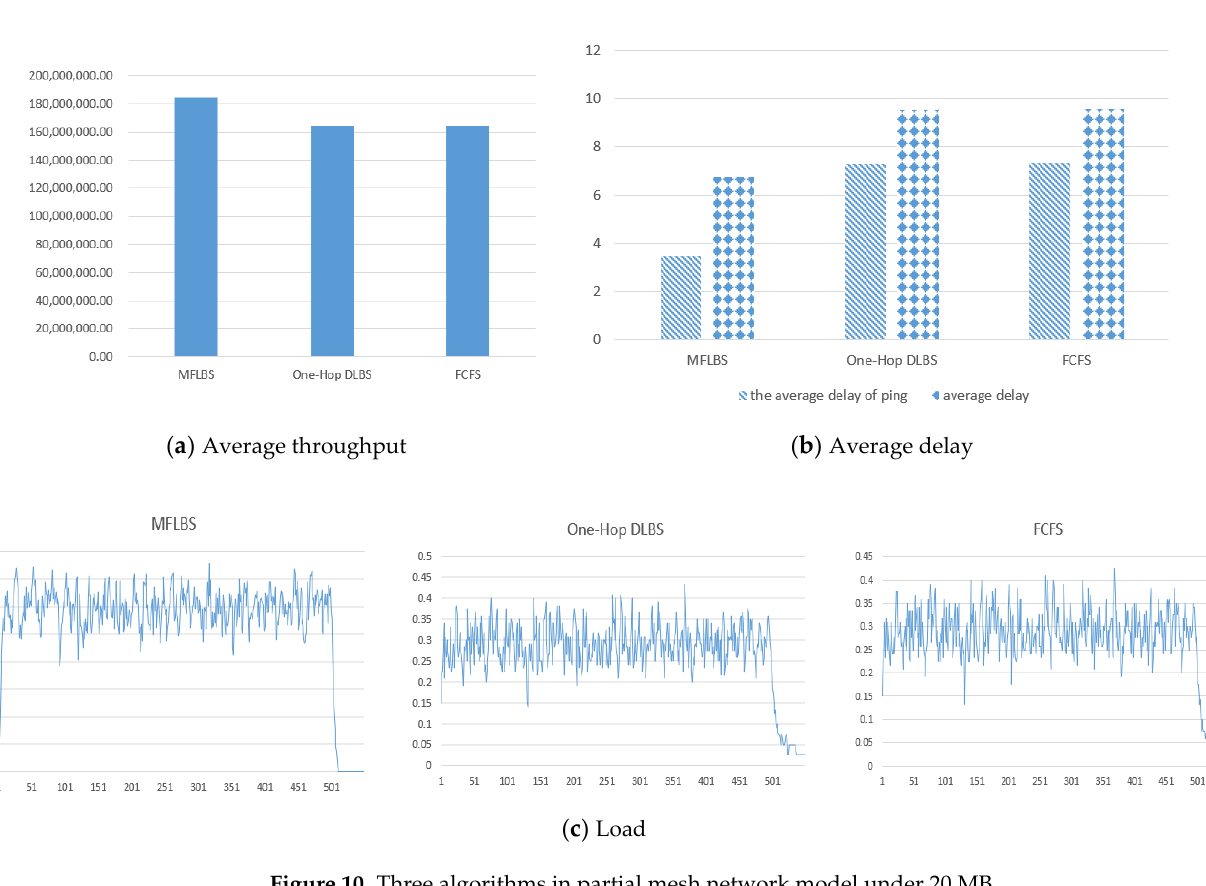
Figure 9. Three algorithms in partial mesh network model under 40 MB.